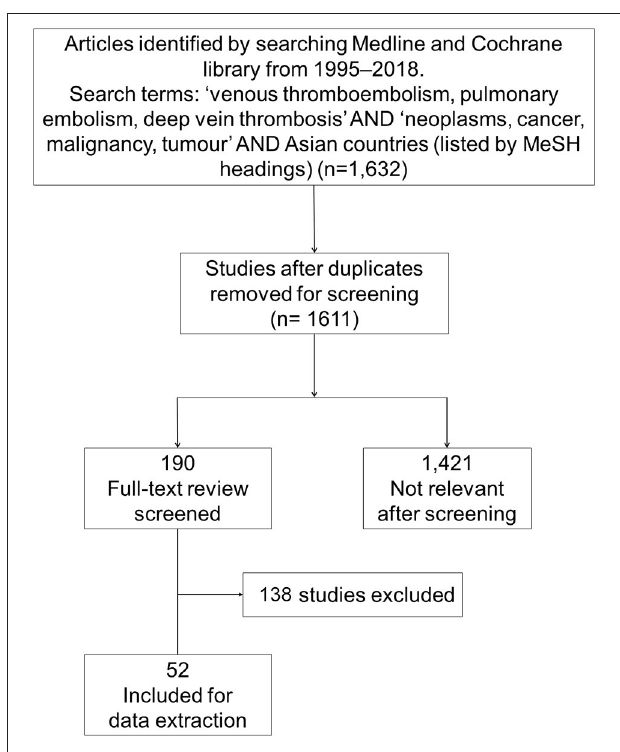
FIGURE 1 | PRISMA flowchart of included